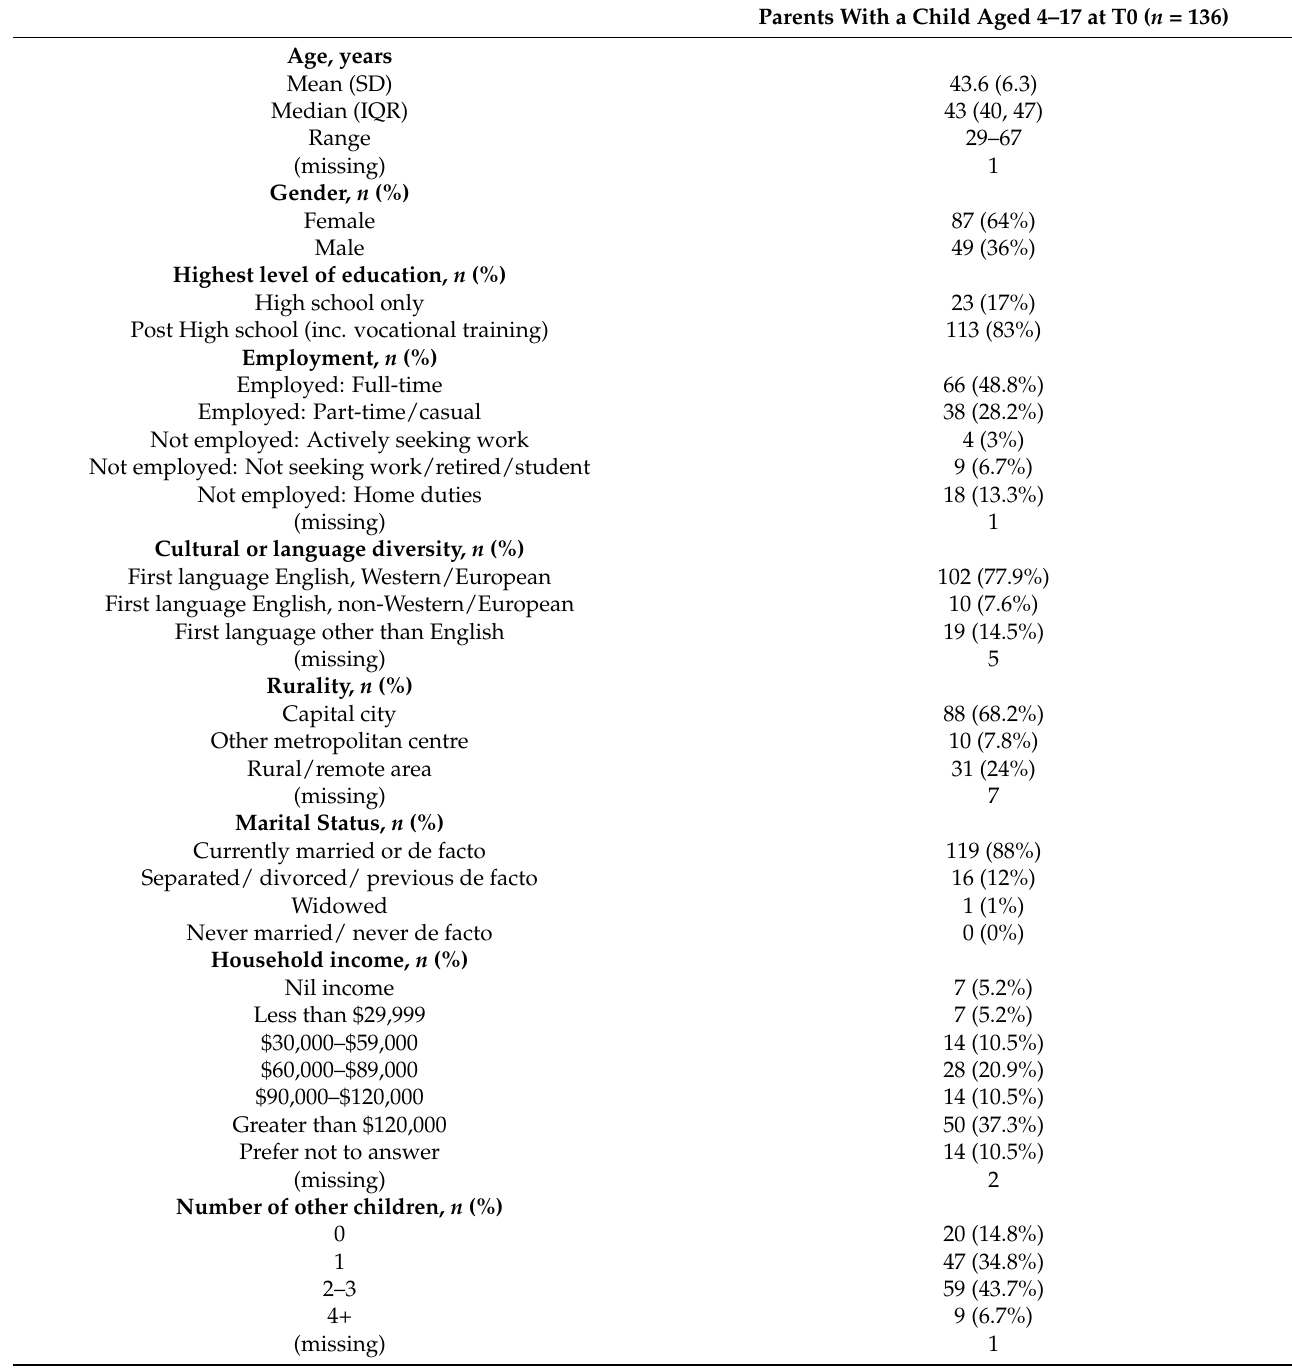
Table 1. Demographics of parents with a child aged 4–17 years at T0 who participated in PRISM- Impact (providing parent-proxy QoL